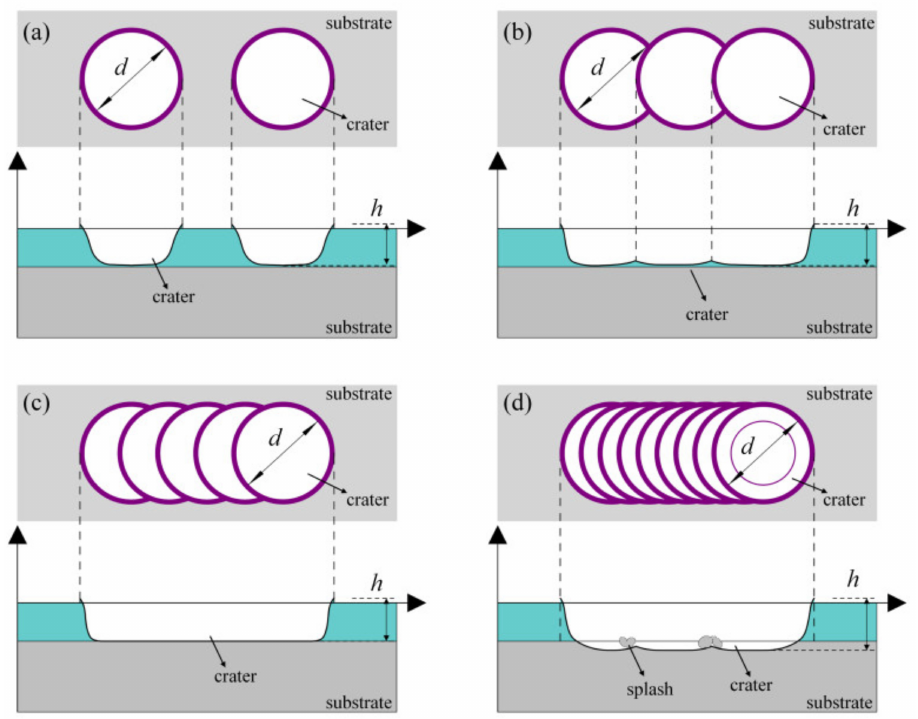
Figure 12. Variation of sample surface roughness with the spot overlap rate of the water jet-guided laser. ( a ) Stage 1; ( b ) Stage 2; ( c ) Stage 3; ( d ) Stage